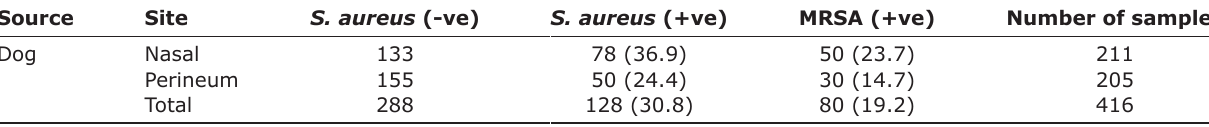
Table-2: Percentage distribution of S. aureus and MRSA isolated from hunting dogs in Maiduguri metropolitan.